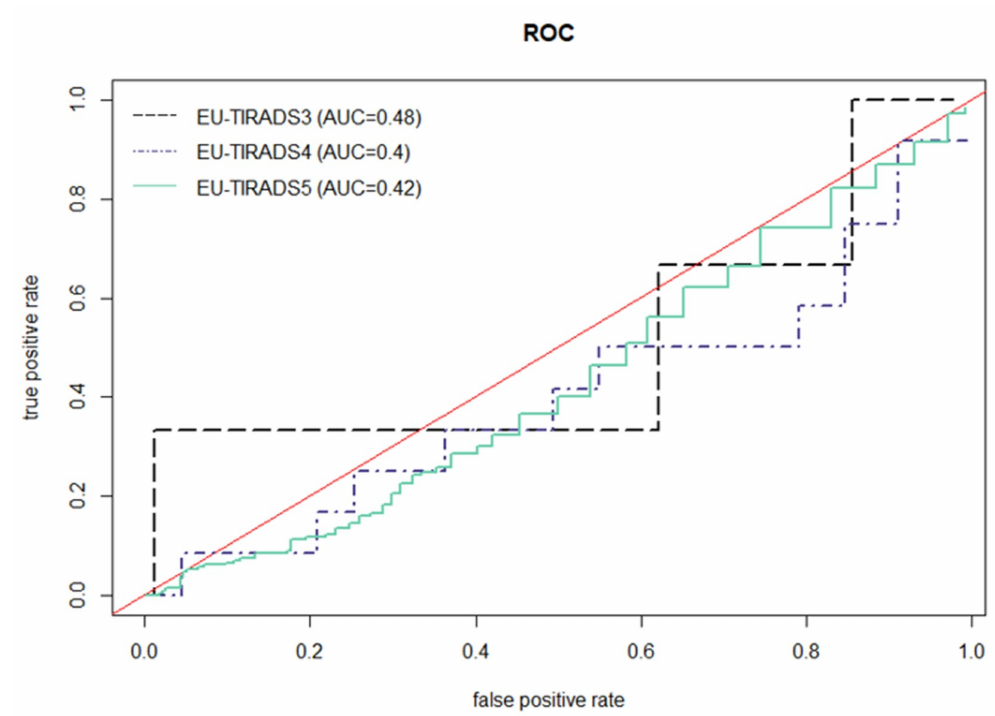
Figure 2. The receiver operating characteristic (ROC) curves show true positive rates versus false positive rates corresponding to di ff erent size thresholds (in mm) to perform fine needle aspiration biopsy (FNAB).